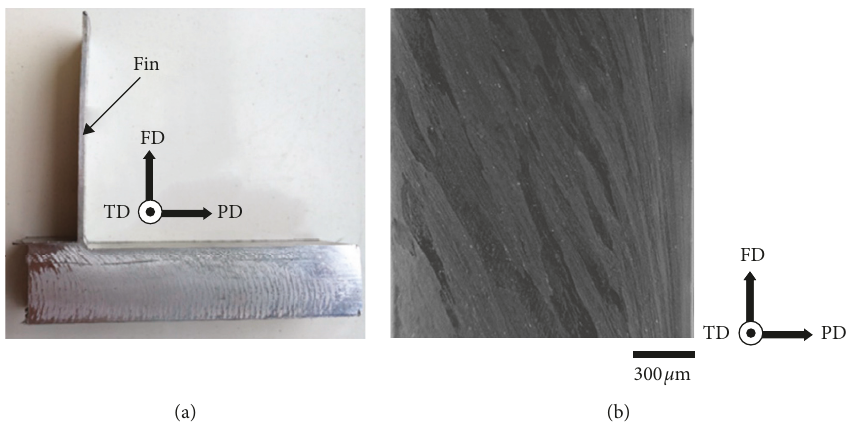
Figure 3: (a) A sample after PFM processing. (b) SEM microstructure across the thickness of the fin for the case of t